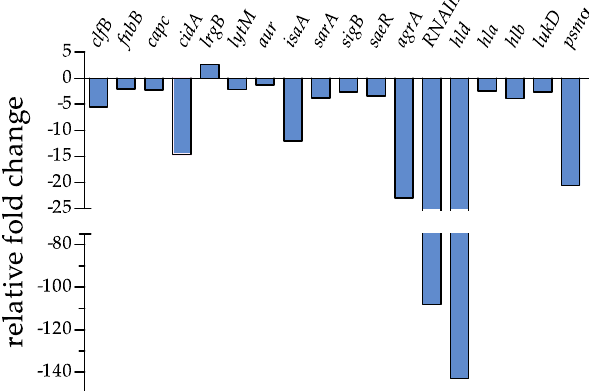
Figure 3. Transcriptional profile changes in S. aureus after treatment with PYED-1, determined by qRT-PCR with respect to rpoB expression. Fold-changes were calculated using treated versus untreated S. aureus cells. Gene descriptions, fold changes, standard deviations (SD), and p -values are reported in Table 1. Table 1. RT-PCR analysis of biofilm gene expression in S. aureus ATCC 29213 in the presence of PYED- 1 . Gene Description